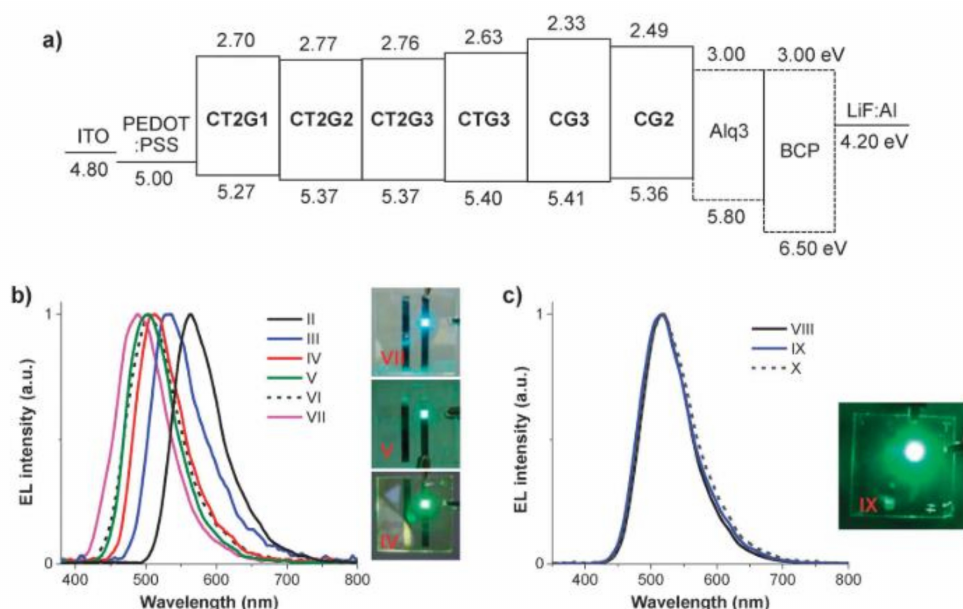
Figure 16. Schematic ( a ) energy diagram of the fabricated organic light emitting diodes (OLEDs). ( b , c ) Emission light spectra of the OLEDs (devices II–X) fabricated with carbazole dendronized coumarin derivatives as an emissive layer and a hole transporting layer and their device emission colors. Reproduced with permission from [32]. Copyright 2014©, Royal Society of Chemistry,